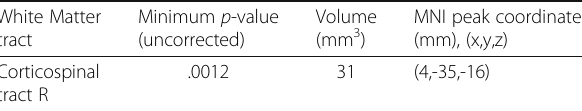
Table 5 White matter regions from the Johns Hopkins University White-Matter Tractography Atlas for which significant decreased AD values were found in CM compared to EM considering the effect of time from onset of CM White Matter tract